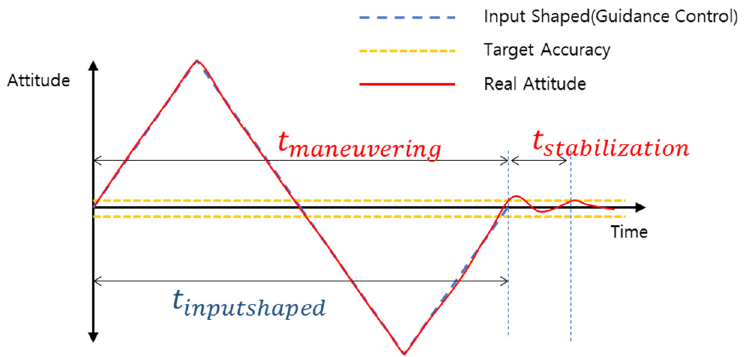
Figure 2. The depiction of maneuvering time, stabilization time, and input shaped time.